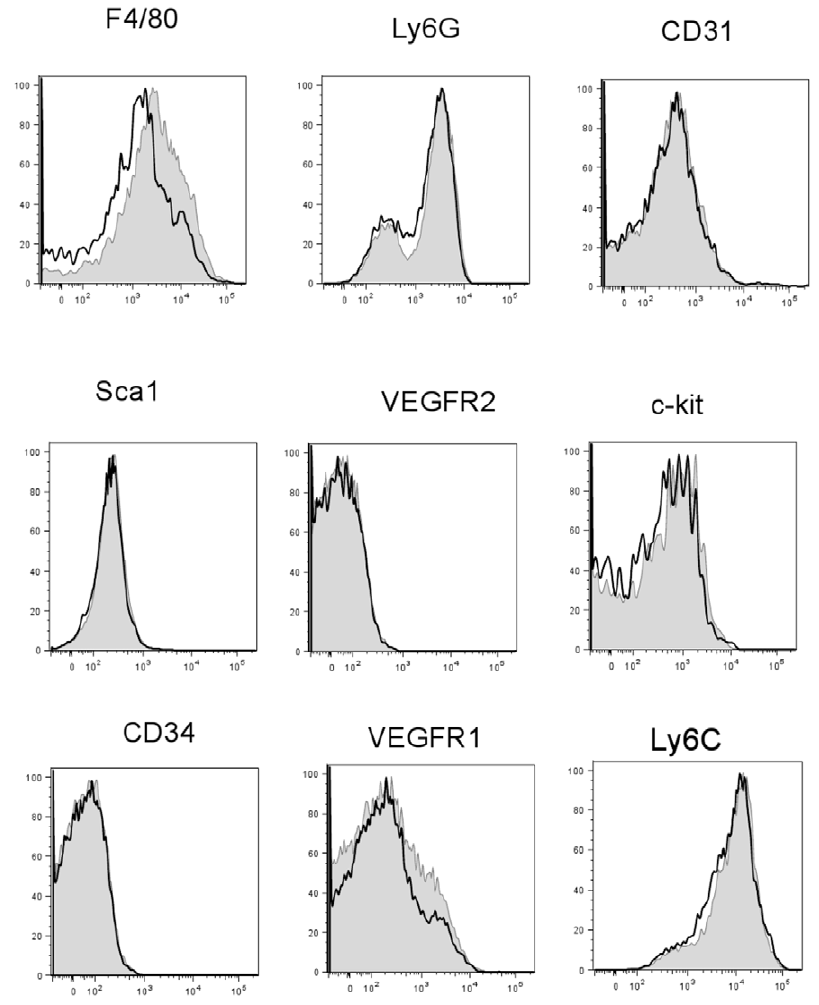
Figure 7. Analysis of cell surface molecules on Gr-1 + CD11b + MDSCs. Spleens were harvested from 3LL tumor bearing WT or Rgs2 2 / 2 mice between days 17–21 post-injection, processed into single cell suspensions, and labeled with antibodies against the indicated cell surface molecules. Representative plots are shown. Experiment was performed 3 times with 3–4 mice per group. Shaded=WT, open=Rgs2 2 / 2 .